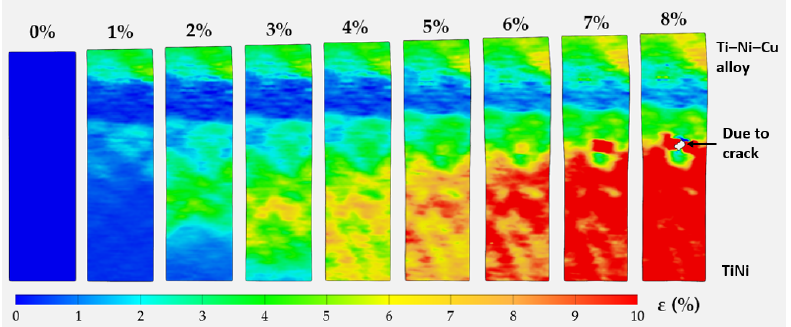
Figure 8. The strain map of the local axial strain within the gauge section at the moments when the total tensile strain equals 0, 1%, 2%, 3%, 4%, 5%, 6%, 7%, and 8%.